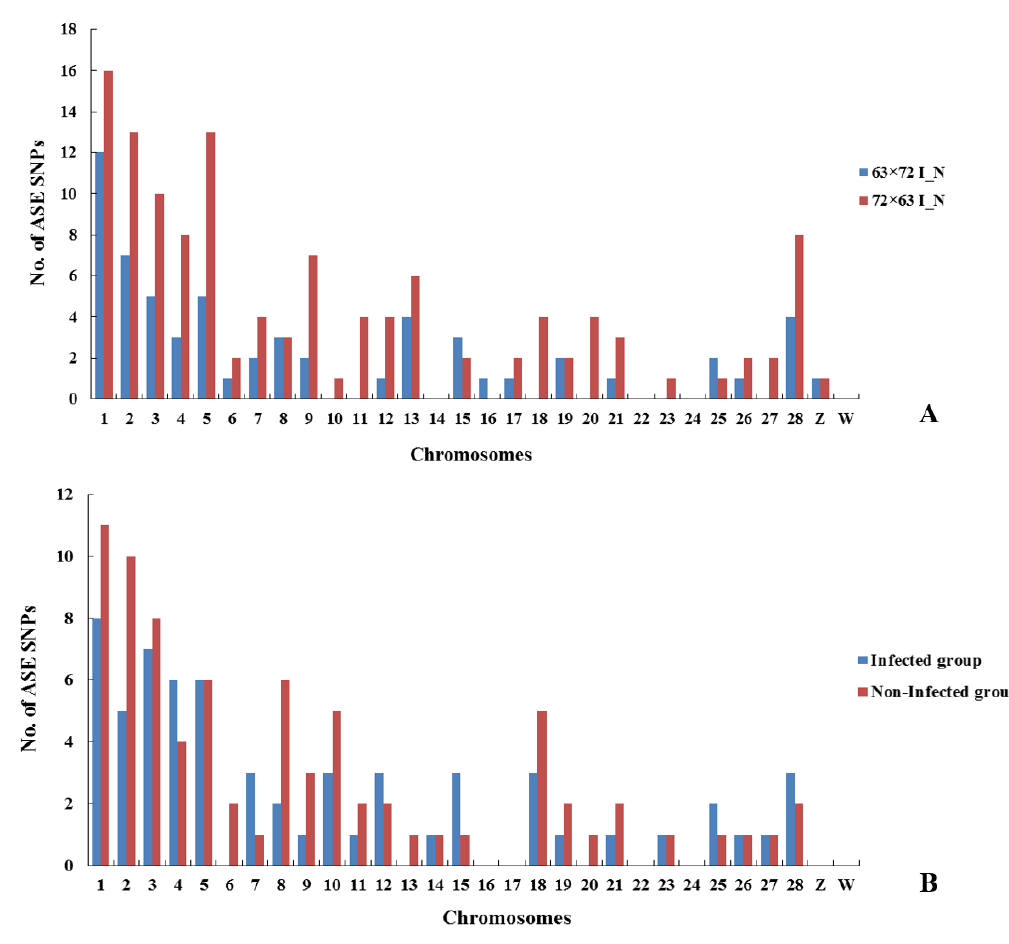
Figure 2. Distribution of ASE SNPs in chicken chromosomes. ( A ) Distribution of ASE SNPs in intercrosses 6 3 × 7 2 and 7 2 × 6 3 , respectively, in response to MDV infection. ( B ) Distribution of ASE SNPs between two reciprocal crosses in infected and non-infected groups. 242